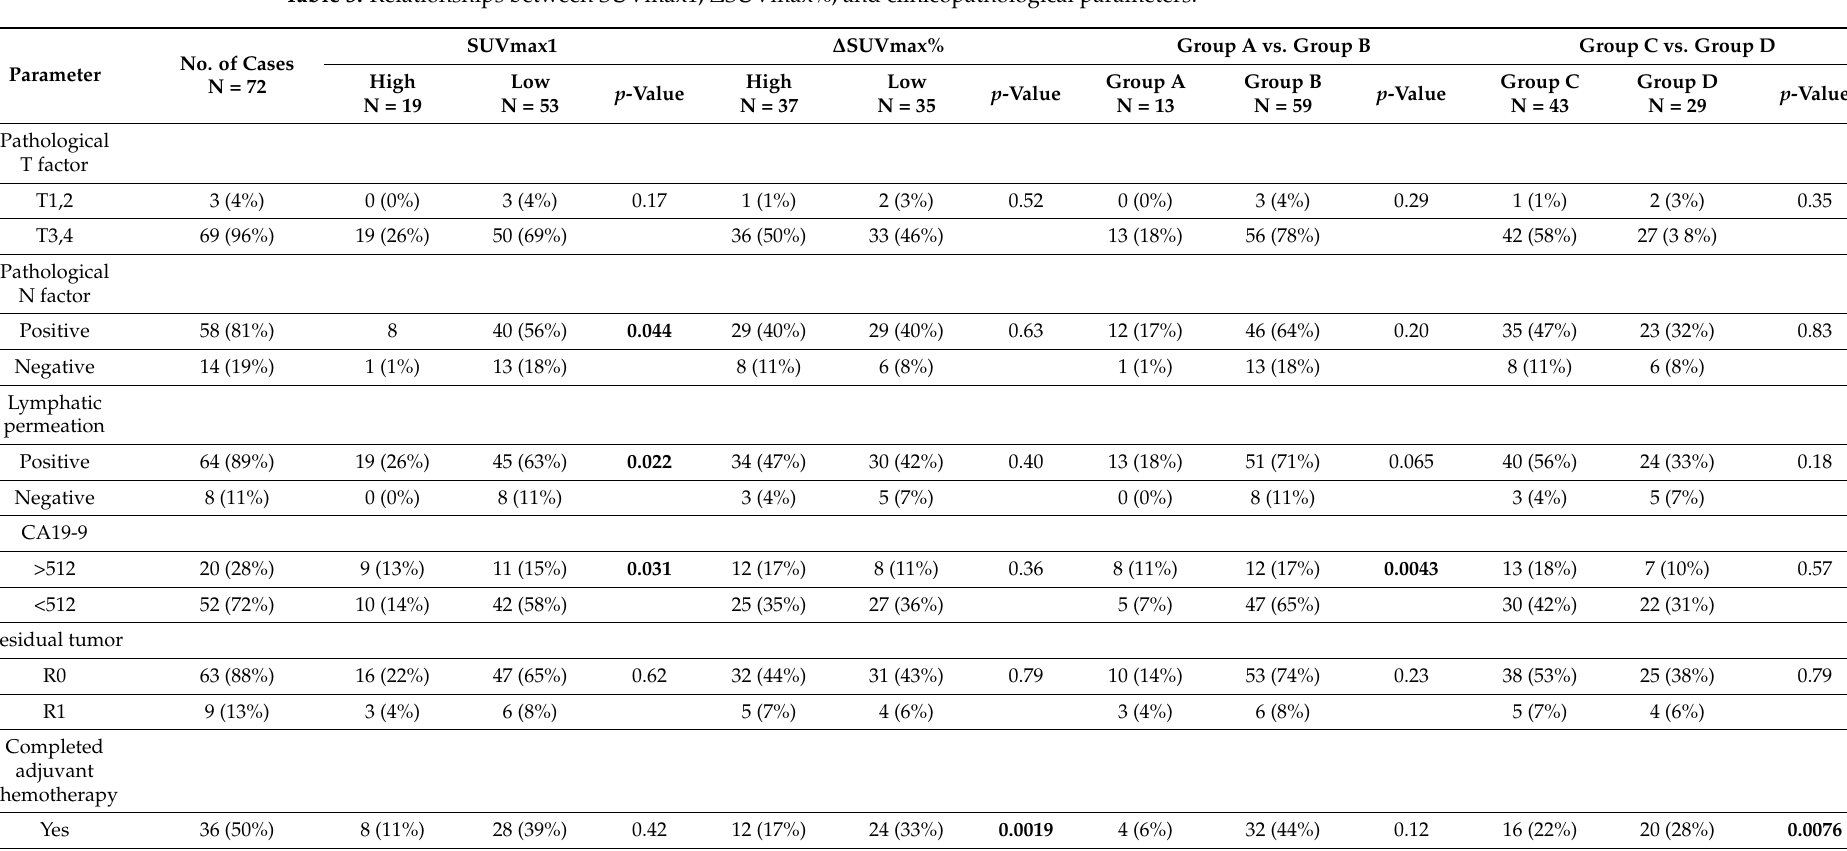
Table 3. Relationships between SUVmax1, ∆ SUVmax%, and clinicopathological